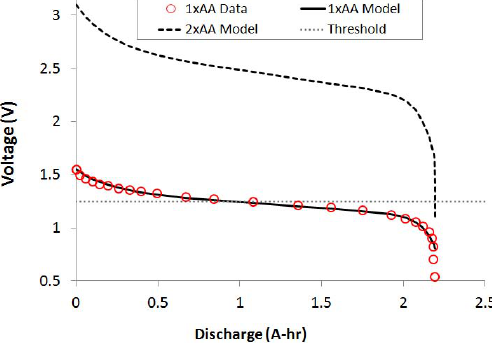
Fig. 2. Discharge curve of a Duracell alkaline AA cell (50mA constant current) from manufacturer’s datasheet (circles), compared with a simple analytic model C =Co/[1+exp { (V − V o)/ d V }] with Co=2.2A-h, Vo=1.25V and d V =0.07V (solid line). Where this curve intersects the voltage threshold of the logger (dotted line), the unit stops – in this case (threshold=1.25V) after a discharge of about 1A-h – even though substantial capacity remains. One miti- gation is to put two cells in series (dashed curve) – here the curve intersects the threshold after some 2.2A-h. The rather shallow dis- charge curve of alkaline cells means that if the threshold is even slightly higher, a significant drop in useful battery capacity results.